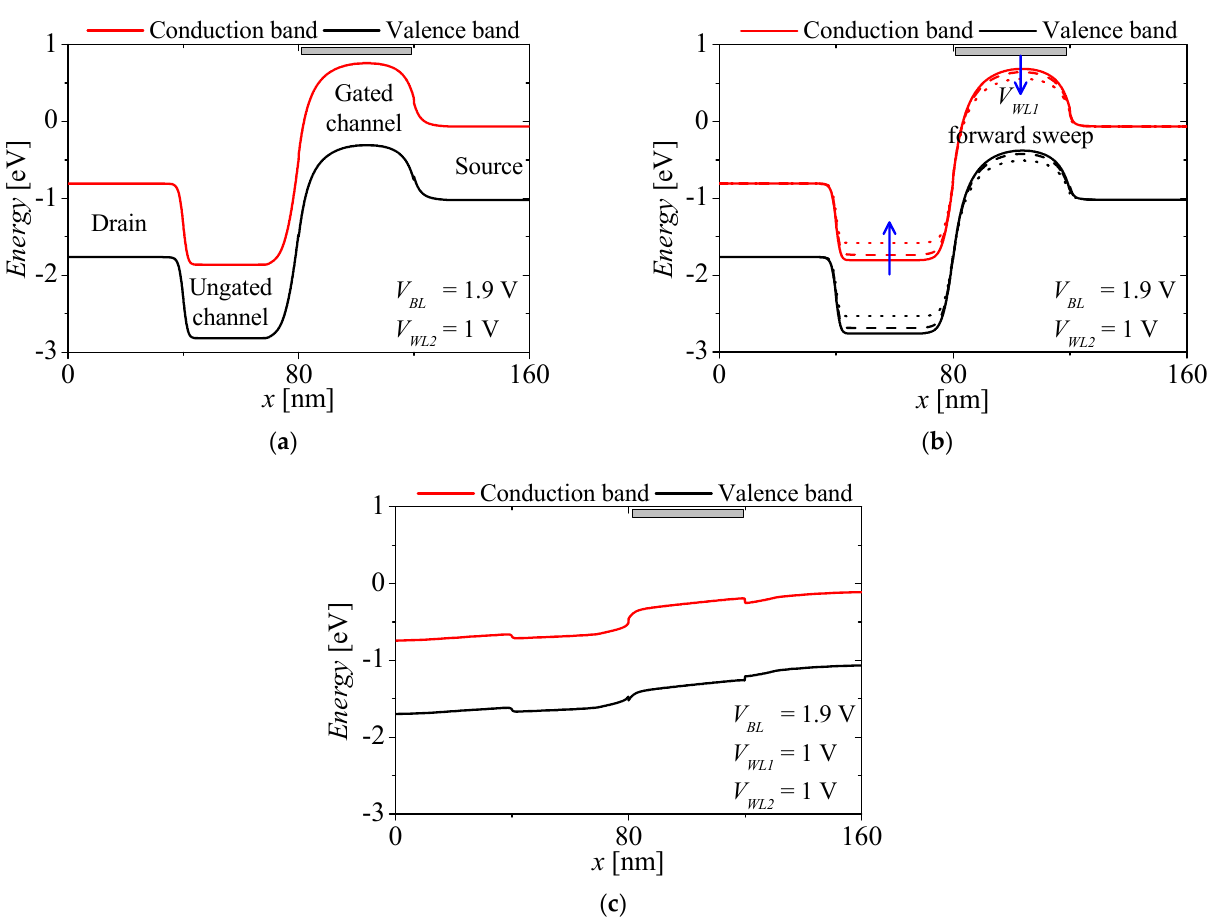
Figure 2. The energy band diagram of the NFBFET in the M3D − FBFET − SRAM cell. ( a ) Initial state ( V BL = 1.9 V, V WL2 = 1 V, and V WL1 = 0 V), ( b ) V WL1 forward sweep ( V BL = 1.9 V and V WL2 = 1 V), ( c ) on − state ( V BL = 1.9 V and V WL1 = V WL2 = 1 V).